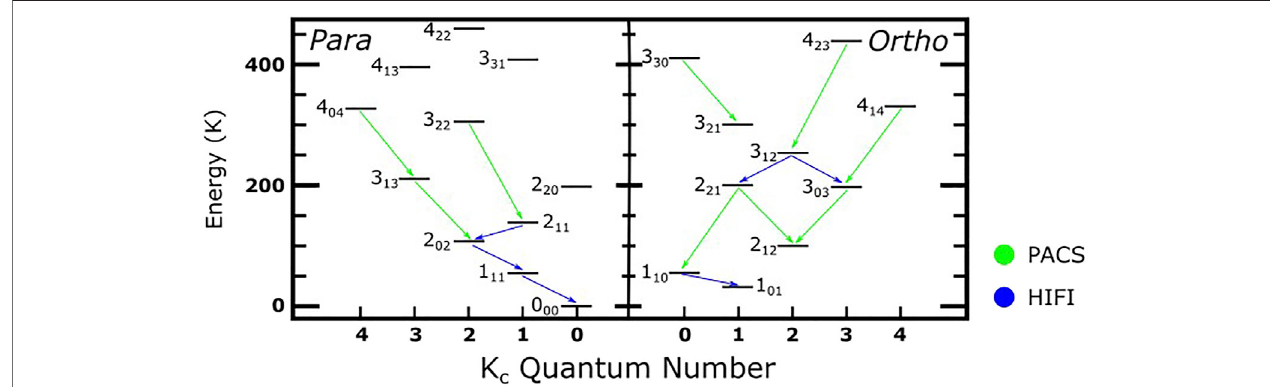
FIGURE 4 | Energy level diagram of ortho- and para-H 2 O showing the transitions observed by the PACS and HIFI instruments aboard the Herschel Space Observatory. Further information may be found in the work of van Dishoeck et al. (2013).